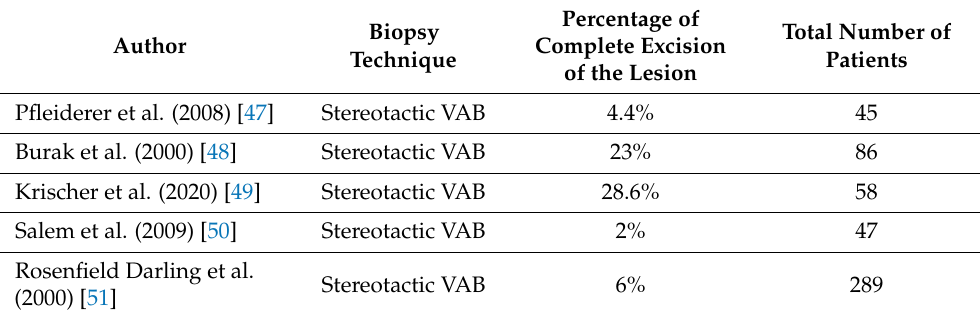
Table 9. Literature review: rate of complete excision of DCIS with vacuum-assisted biopsy